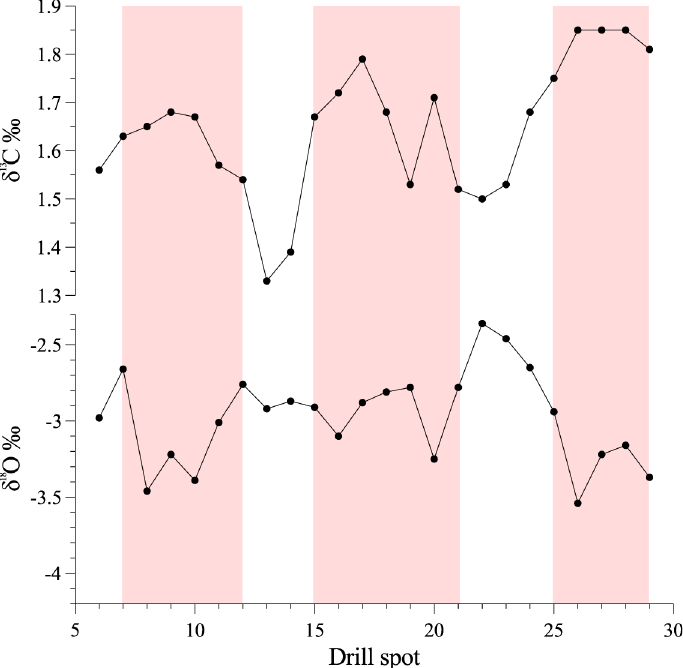
Fig 4. Isotope data from UOM-232 showing the white and pink (shaded) bands and the location of the drill spots.